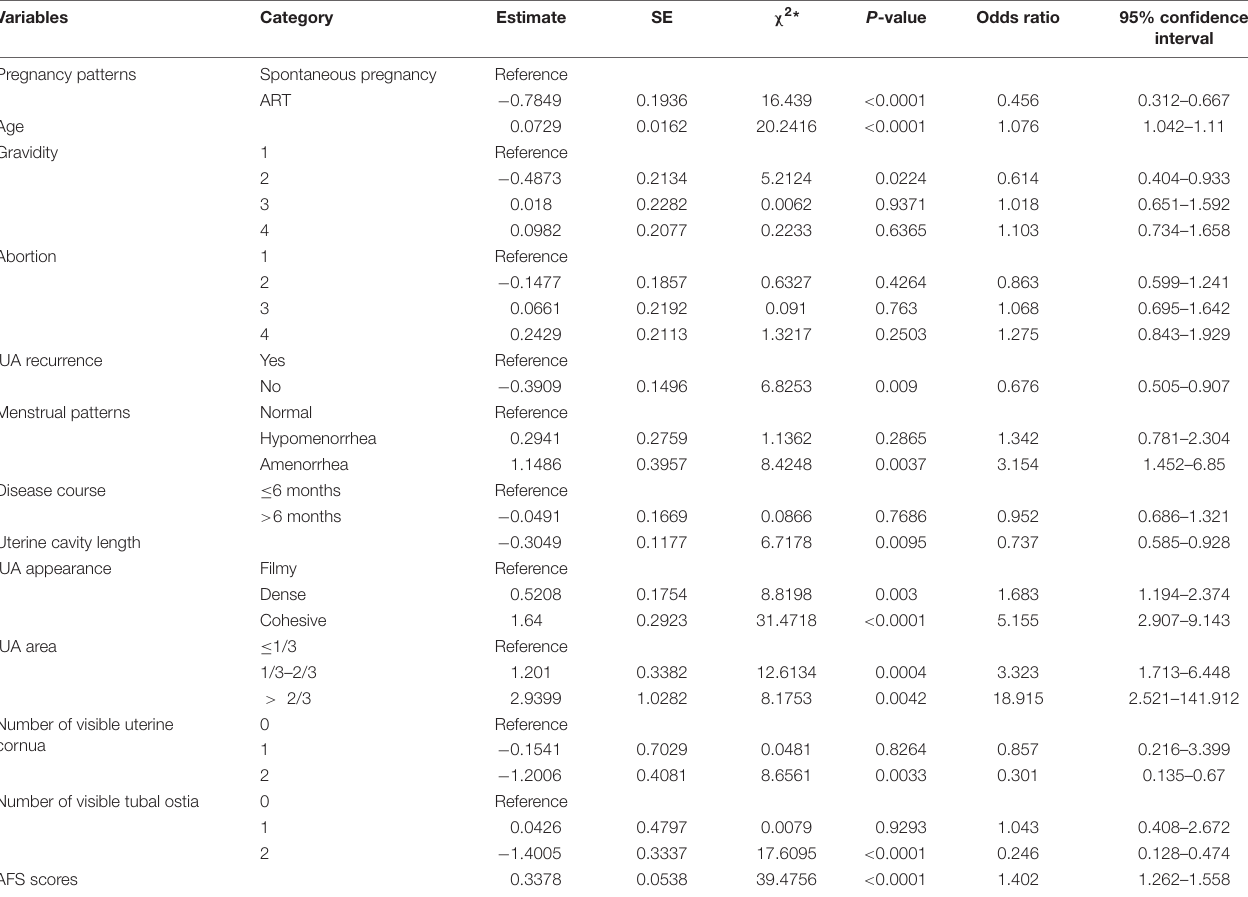
TABLE 2 | Univariate analysis of the live birth and non–live birth groups.